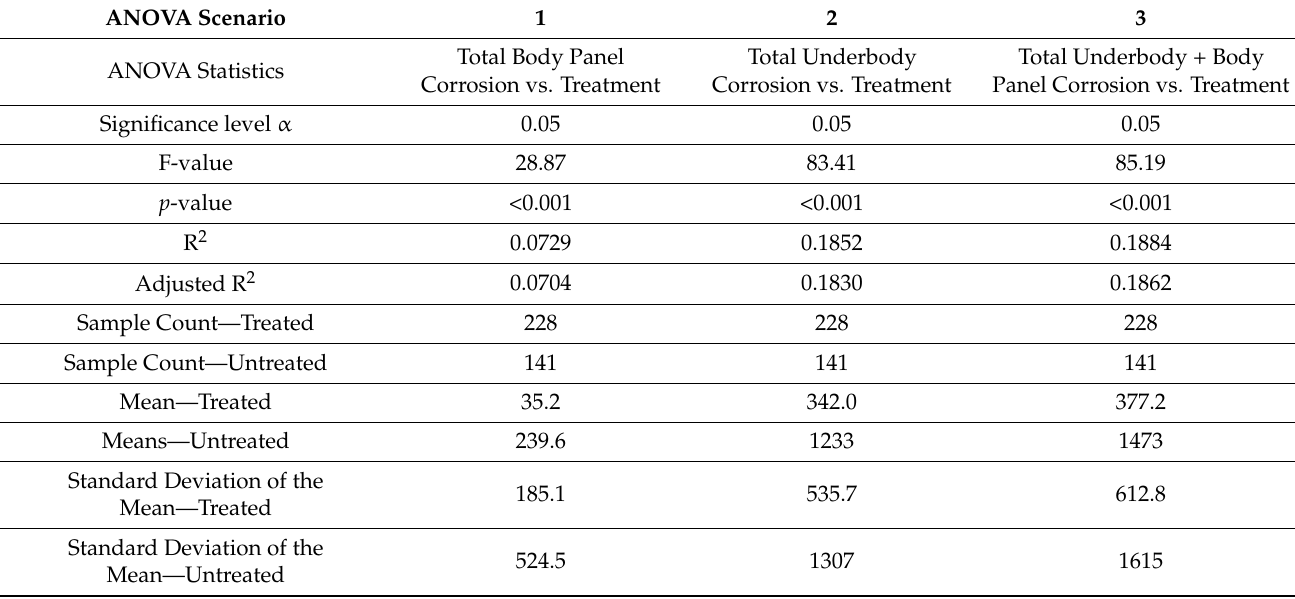
Table 2. Summary of statistics for single-factor ANOVA analysis of corrosion index versus treatment for treated and untreated vehicles.